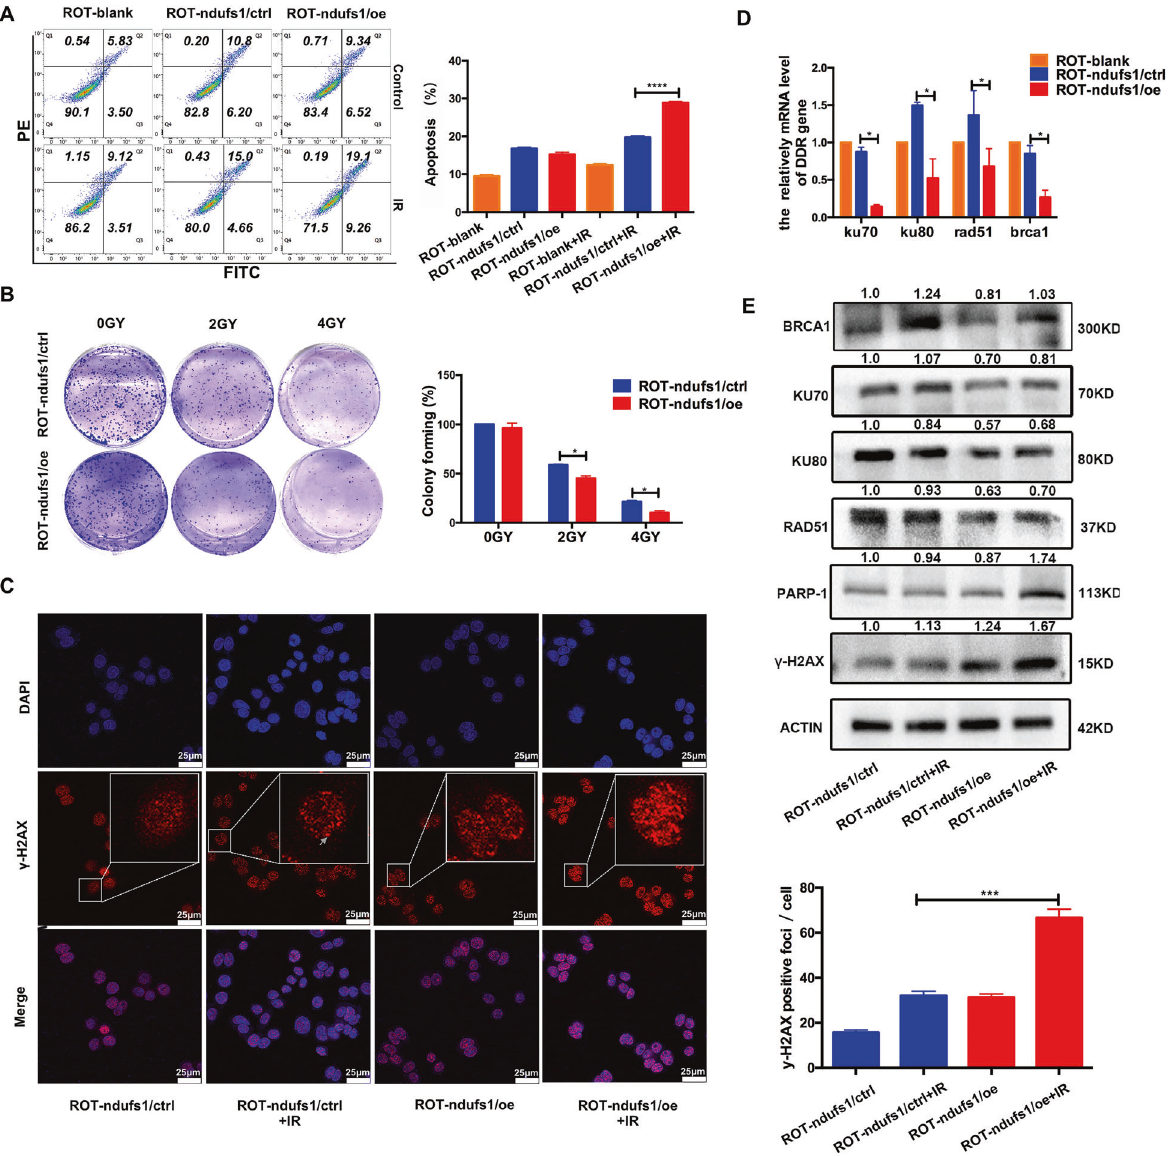
Fig. 5 Enhancing mitochondrial complex I activity induced by NDUFS1 overexpression sensitized CRC cells to radiation. A , B Apoptosis ( A ) and colony formation assay ( B ) in ROT-ndufs1/ctrl and ROT-ndufs1/oe cells with or without 4 Gy X-ray irradiation. ( n = 4), * P < 0.05, **** P < 0.0001. C IF staining of γ -H2AX foci (red) and DAPI (blue) in ROT-ndufs1/ctrl and ROT-ndufs1/oe cells with or without 4 Gy X-ray irradiation. Inset shows magni fi ed areas, scale bar: 25 μ m. Foci per cell was calculated, ( n = 6), *** P < 0.001. D – E Overexpression of NDUFS1 could decrease mRNA and protein level of DDR genes. ( n = 5), * P < 0.05, Data are presented as the means ±